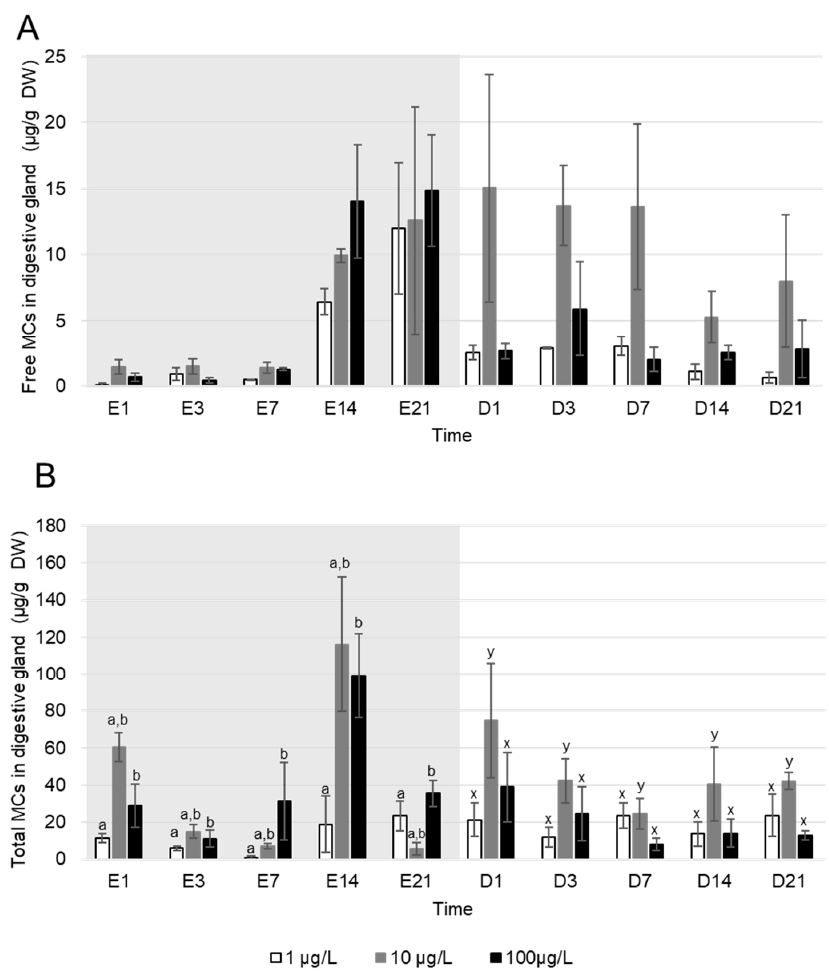
Figure 2. Mean ± S.E.M concentrations ( µ g / g DW) of ( A ) free and ( B ) total MC accumulated in the digestive glands of A. anatina exposed to P. agardhii producing an equivalent of 1 (white), 10 (grey) and 100 (black) µ g MC / L, during the exposure (days with the letter E, grey background) and the depuration (days with the letter D, white background), n = 3 pools of 6 individuals. No significant di ff erence between concentrations of the same sampling time (Kruskal–Wallis test, p > 0.05). Letters indicate di ff erence in MC accumulation (Kruskal–Wallis, p < 0.05) between exposure concentration series during the exposure (a and b), and the depuration (x and y). Table 1. Total MC concentrations ( µ g MC / g DW) in whole A. anatina and digestive glands of D. polymorpha at days 3, 7 and 21 of exposure and day three of depuration in mussels exposed to a density of P. agardhii producing an equivalent of 1, 10 and 100 µ g MC / L. Data not shown due to technical di ffi culties are referred as ND (Not